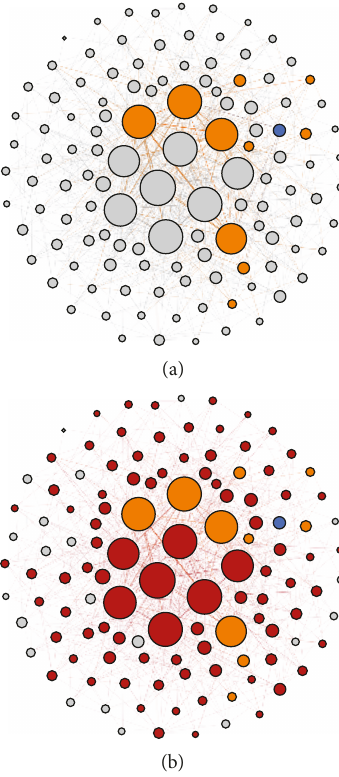
Figure 4: Information availability in the banking network of 120 banks in two local information (LI) scenarios: LI1 and LI2. In the LI1 scenario (a), information is available up to distance 1 in the network. That is, the bank in blue receives information only from the orange banks — its immediate neighbors. In the LI2 scenario (b), information is available up to distance 2. That is, the bank in blue receives information not only from the orange banks but also from the red banks — its neighbors of neighbors. The remaining banks are colored in grey. The node size is weighted by its degree. The network is constructed using the default values of model parameters (Section